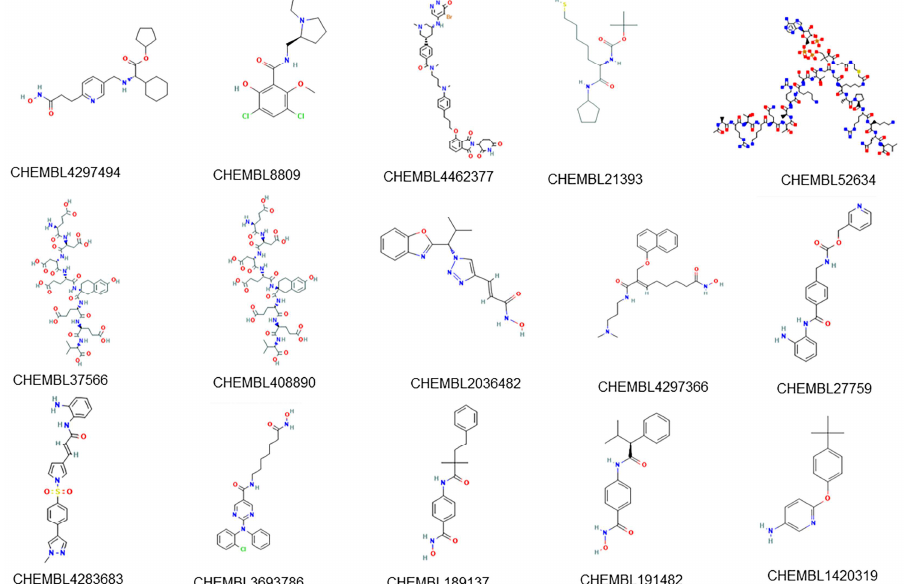
Figure 8. Prediction results of 15 new compounds that were not involved in the generation of our multiple models. The red box represented different objects, such as: DNMT, HDAC, and so on. 2.5. Molecular Docking Verification In order to verify the multi-target predicting results of our algorithm, molecular docking analysis was conducted by the software AutoDock Vina [25]. Here we verified the binding sites of the first approved HDAC inhibitor, vorinostat with target protein HDAC1 and the predicted target protein DNMT1 (Figure 9A,B). Then the binding modes